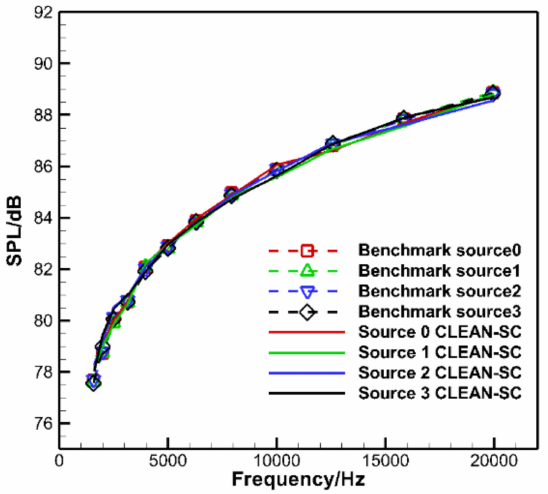
Figure 3. Comparison between the present results and the benchmark case for subcase